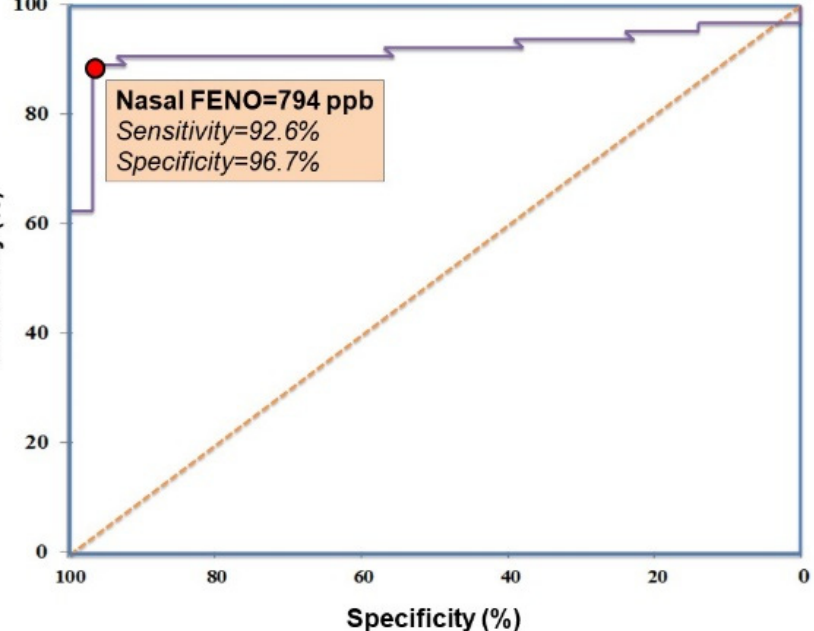
Figure 2. ROC curve of the nasal FENO cut-off for the diagnosis of AR. AR: allergic rhinitis; FENO: fractional exhaled nitric oxide. Table 4. Cut-off nasal FENO with corresponding AR diagnosis sensitivity and